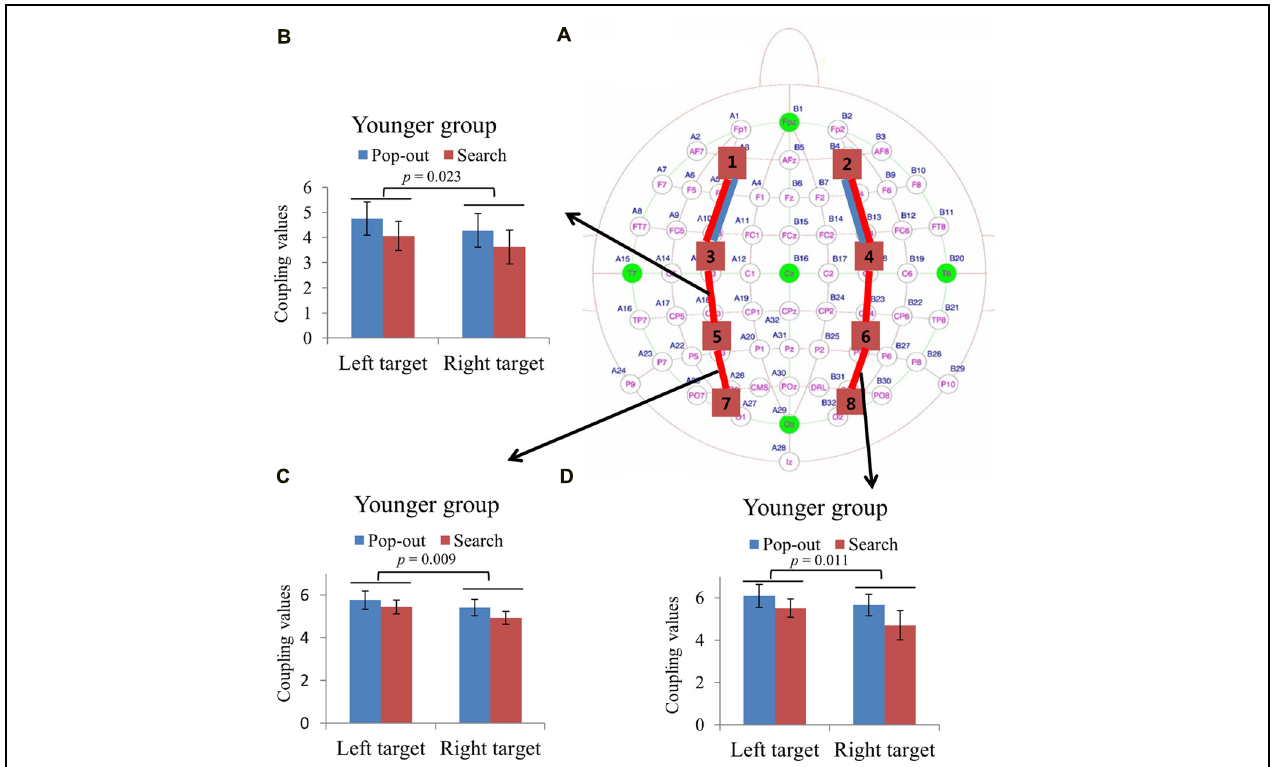
FIGURE 5 | (A) Inter-regions coupling in beta frequency band. Blue lines indicate main effect of age (younger > older) and red line indicates main effect of condition (pop-out > search). Coupling values between left central-frontal and central-parietal regions (B) , between left central-parietal and parietal-occipital regions (C) , and between right central-parietal and parietal-occipital regions (D) as a function of target field and condition in younger subjects, with bigger coupling values in left target than in right target, and no such effect was presented in the older